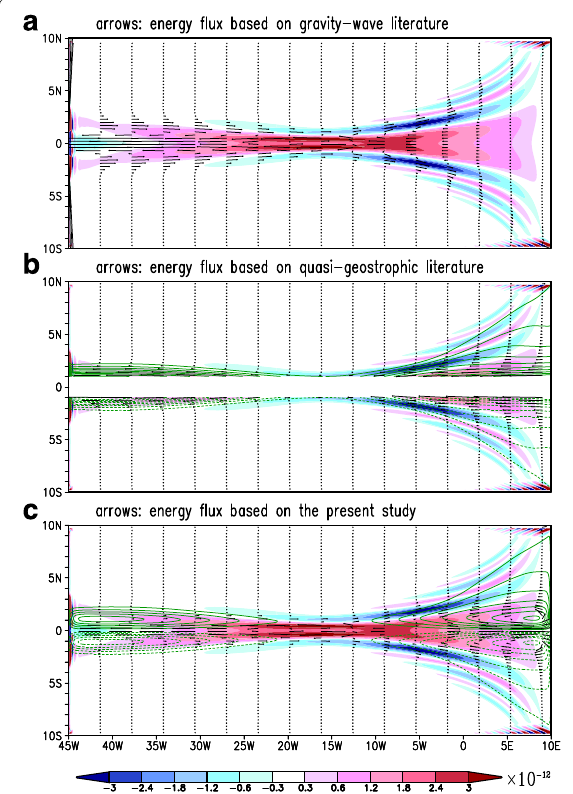
Fig. 6 Comparisons of three expressions for the horizontal flux of wave energy ( arrows ): a the pressure flux [see Eq. (3)], b the pressure flux plus the additional rotational flux of Orlanski and Sheldon (1993) [see Eq. (4)], and c the pressure flux plus the additional rotational flux of the present study [see Eq. (15)]. In both b and c , the additional fluxes have been calculated using the rotation operator in the spherical coordinate system to be consistent with the model formulation. Greencontours in b and c show the distributions of p ∗ 2 /( 2 f ∗ ) and p ∗ ϕ app ∗ / 2, respectively ( solid and dottedlines indicate positive and negative values, respectively, with an interval of 10 − 2 m 4 / s 3 ) . Colorshading in all panels shows the horizontal divergence of the time-averaged energy flux. Note that the additional rotational flux in b and c has no influence on the divergence. All quantities have been calculated from the output of the same experiment with a time-average between t ∗ = 19 T ∗ and 20 T ∗